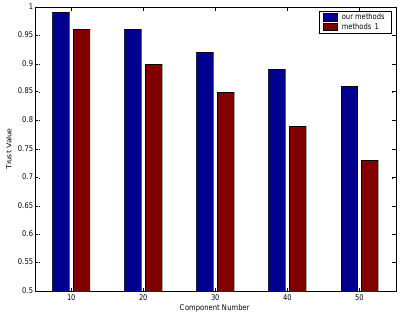
Fig.4.the relationship between the component numbers with the trust